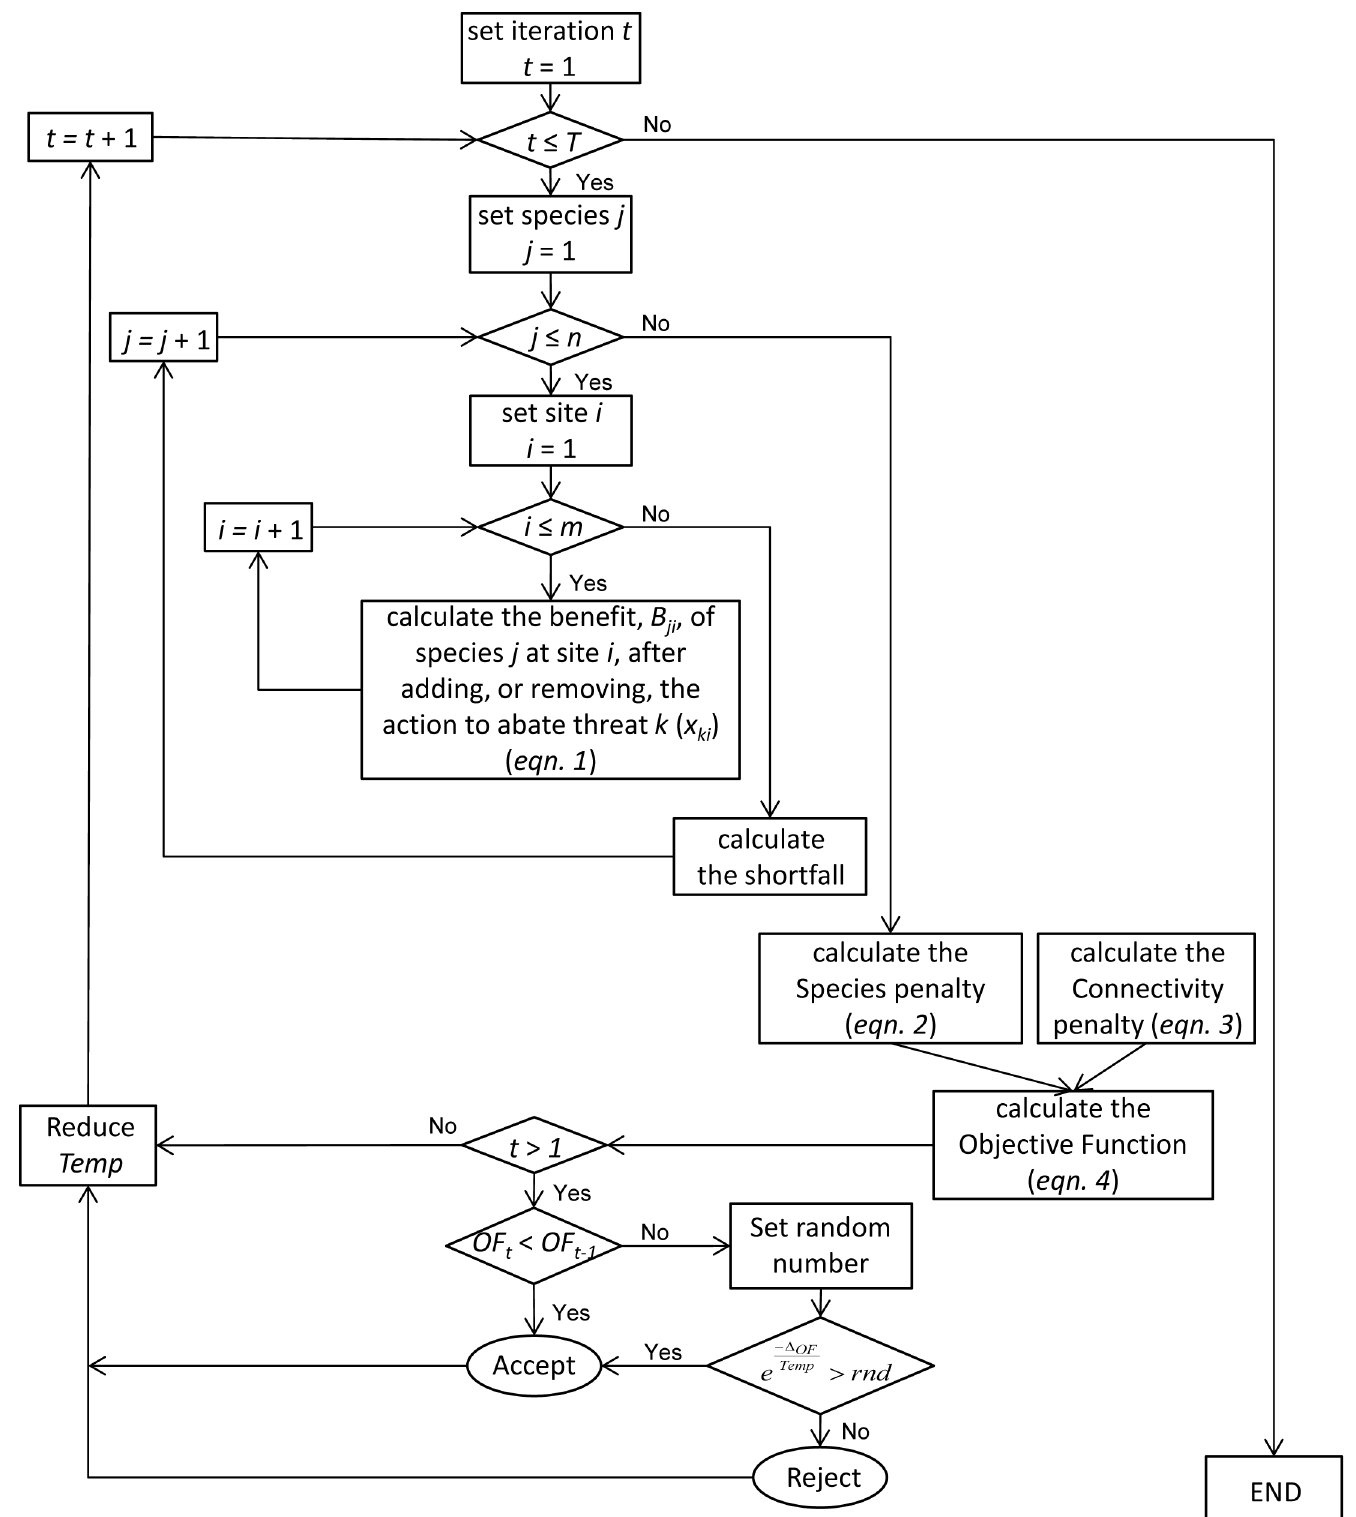
Fig 1. Schematic diagram of the steps of the action optimization algorithm. T is the number of iterations; n is the number of species; m is the number of sites; Δ OF is the difference between the value of the objective function at iteration t and the value of the objective function at iteration t -1; rnd is a number randomly drawn from a uniform distribution; Temp is the temperature parameter. doi:10.1371/journal.pone.0128027.g001 PLOS ONE | DOI:10.1371/journal.pone.0128027 May 28,